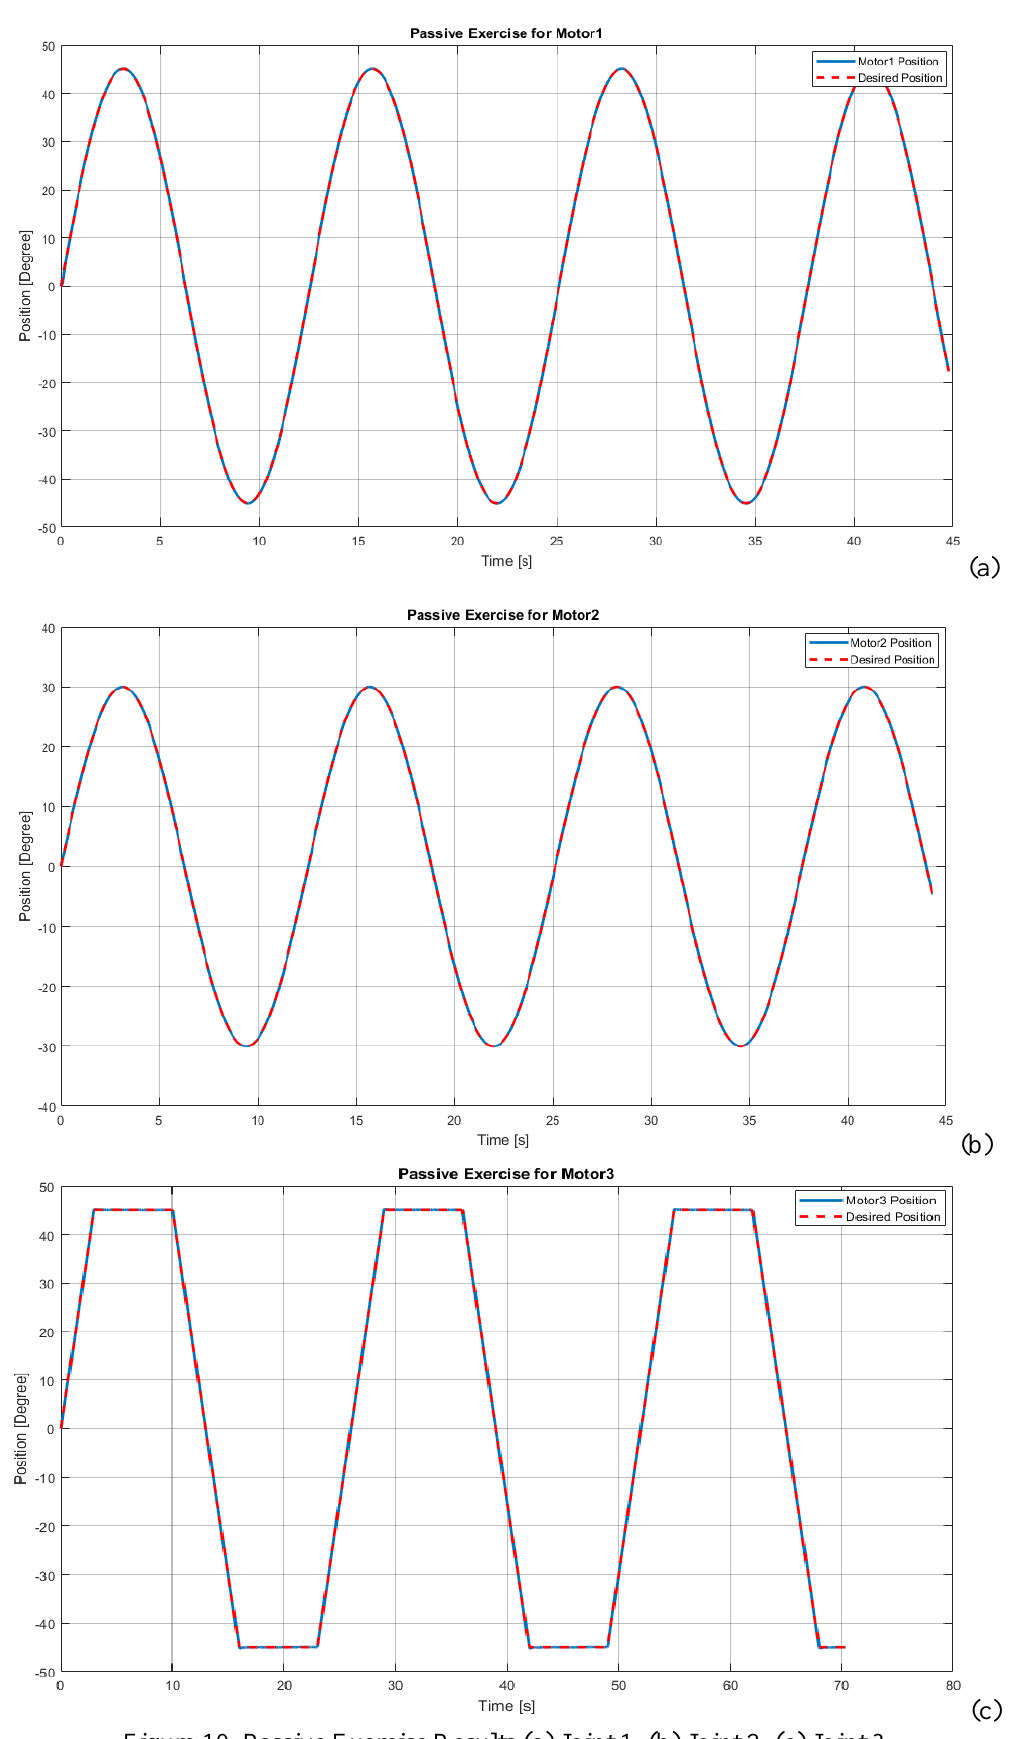
Figure 19. Passive Exercise Results (a) Joint 1, (b) Joint 2, (c) Joint